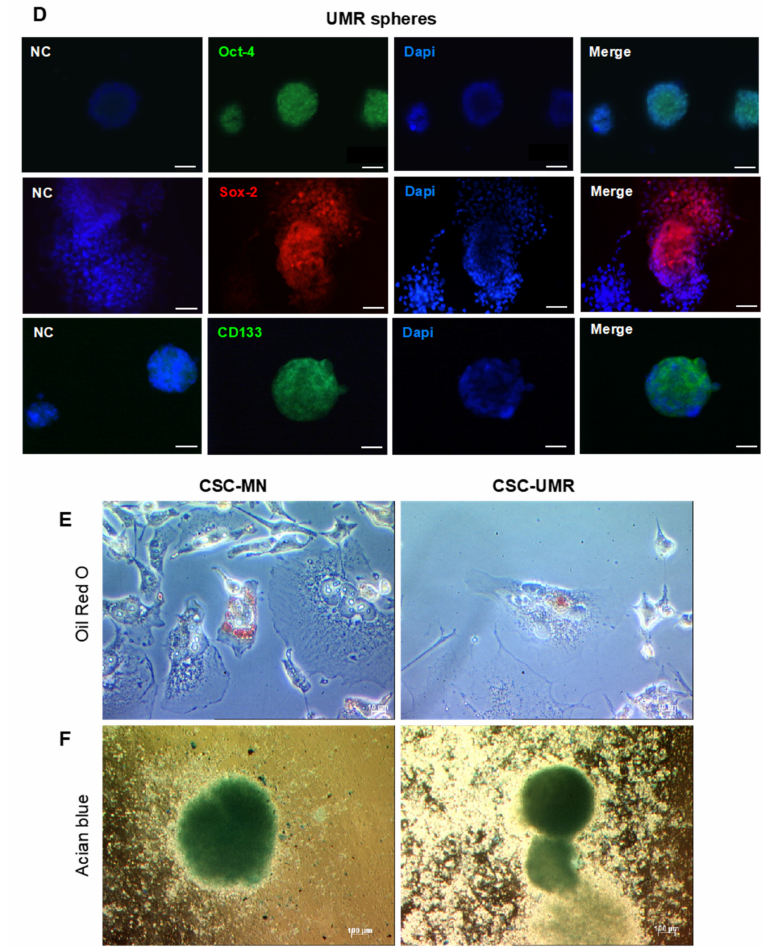
Figure 2. Isolation and characteristics of Cancer stem cell (CSC)-enriched populations from OS cell lines. ( A , B ) Representative pictures of human MN and rat UMR cells grown as monolayers or spheres at × 20 and × 40 magnifications. ( C , D ) Immunofluorescent labeling of Oct-4 (green), Sox-2 (red) and CD133 (green) in MN and UMR spheres. Nuclei are stained with Dapi (blue). Samples stained with secondary antibodies alone served as negative controls (NC). Magnification × 20, scale bar: 50 µ m. ( E,F